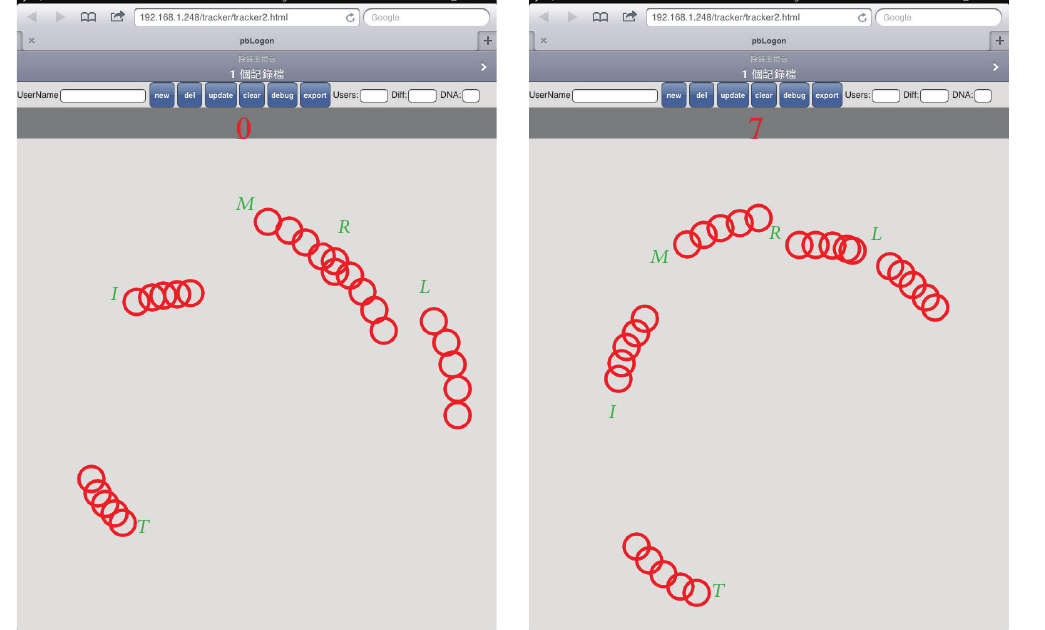
Figure 7: The rotational